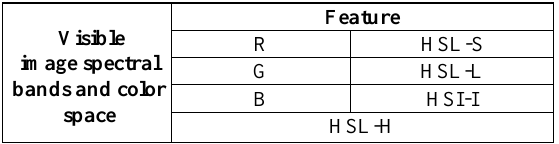
Table 1. Summary of vegetation indices used in this study.